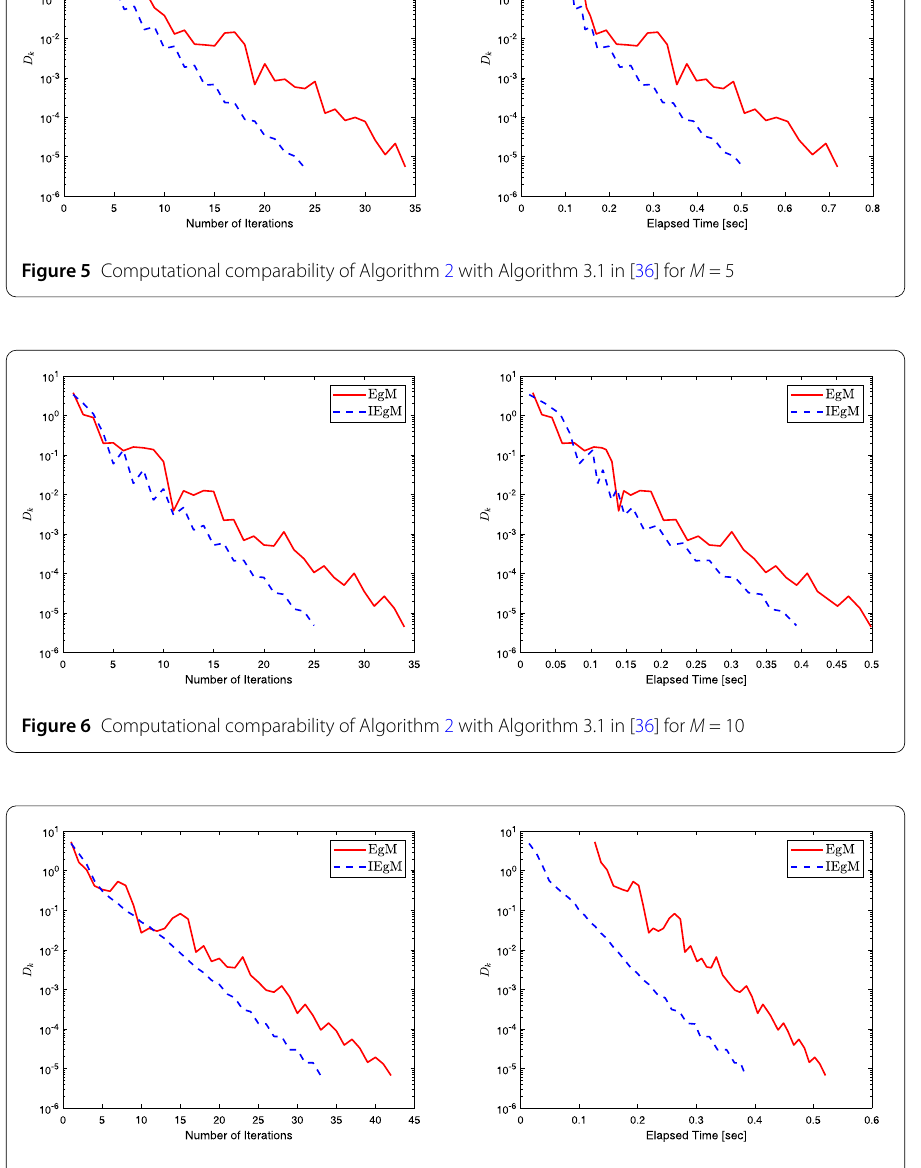
Figure 7 Computational comparability of Algorithm 2 with Algorithm 3.1 in [36] for M =